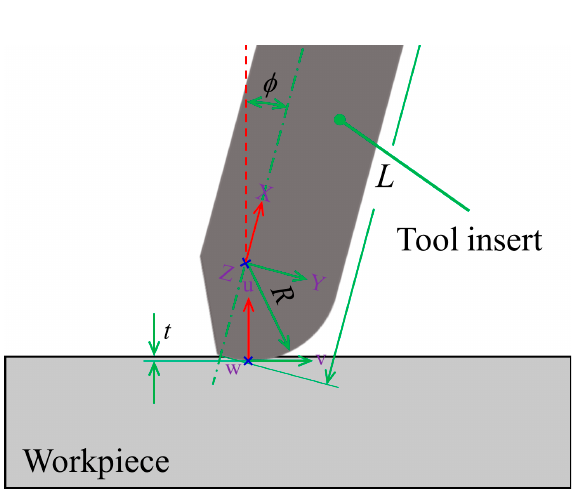
Figure 3. Schematic illustration of the tool chatter impact on the transient DOC in micro-milling.